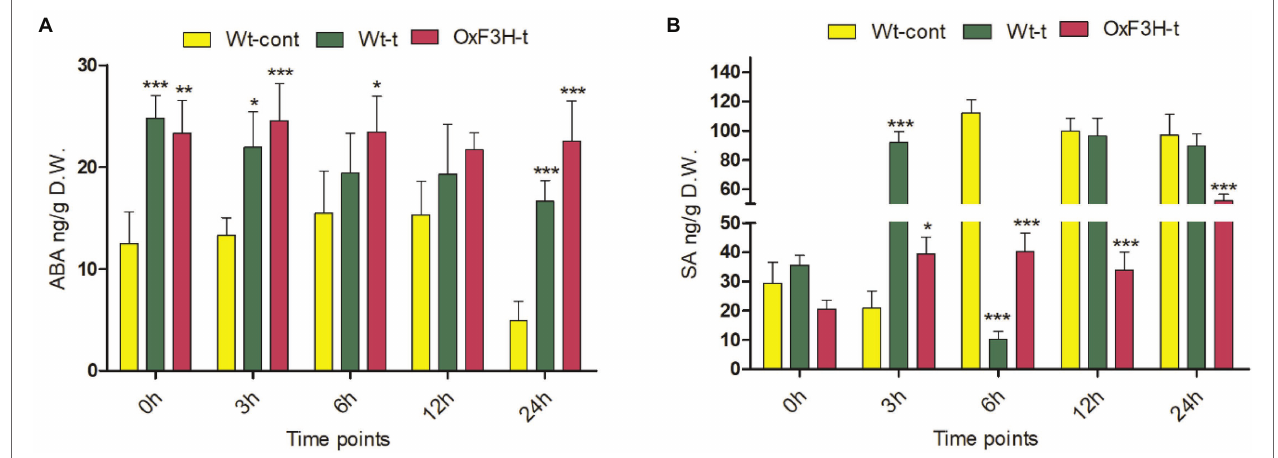
FIGURE 5 | Abscisic acid (ABA) and salicylic acid (SA) are differentially regulated in wild-type and transgenic plants during combined salt and heat stress. (A) ABA and (B) SA accumulation in Wt-cont, Wt-t, and OxF3H-t plants after 0, 3, 6, 12, and 24 h of continuous exposure to stress conditions. Graphs show means ±